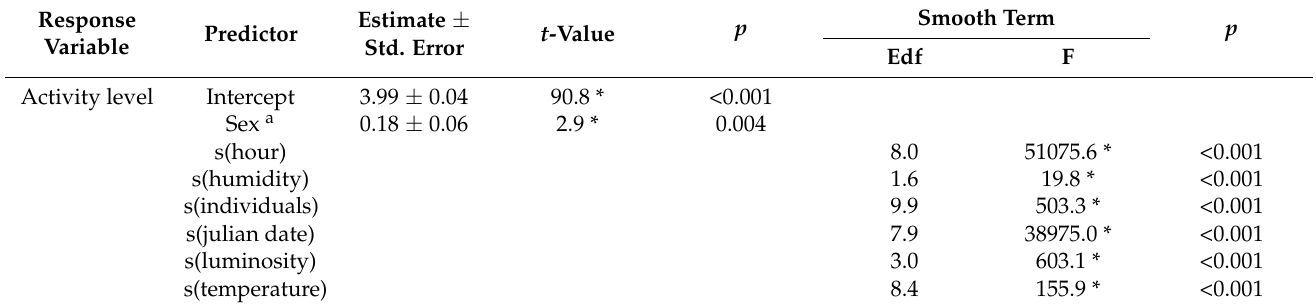
Table 1. Results of Generalized Additive Mixed Models to explain the influence of moon luminosity, seasonality (Julian date), temperature ( ◦ C), relative humidity, time of the day, and individuals (random effect) on the activity levels of Javan slow lorises Nycticebus javanicus in Cipaganti, West Java. Data were collected via accelerometers deployed on 12 Javan slow lorises (six females and six males) between June 2014 and October 2019.